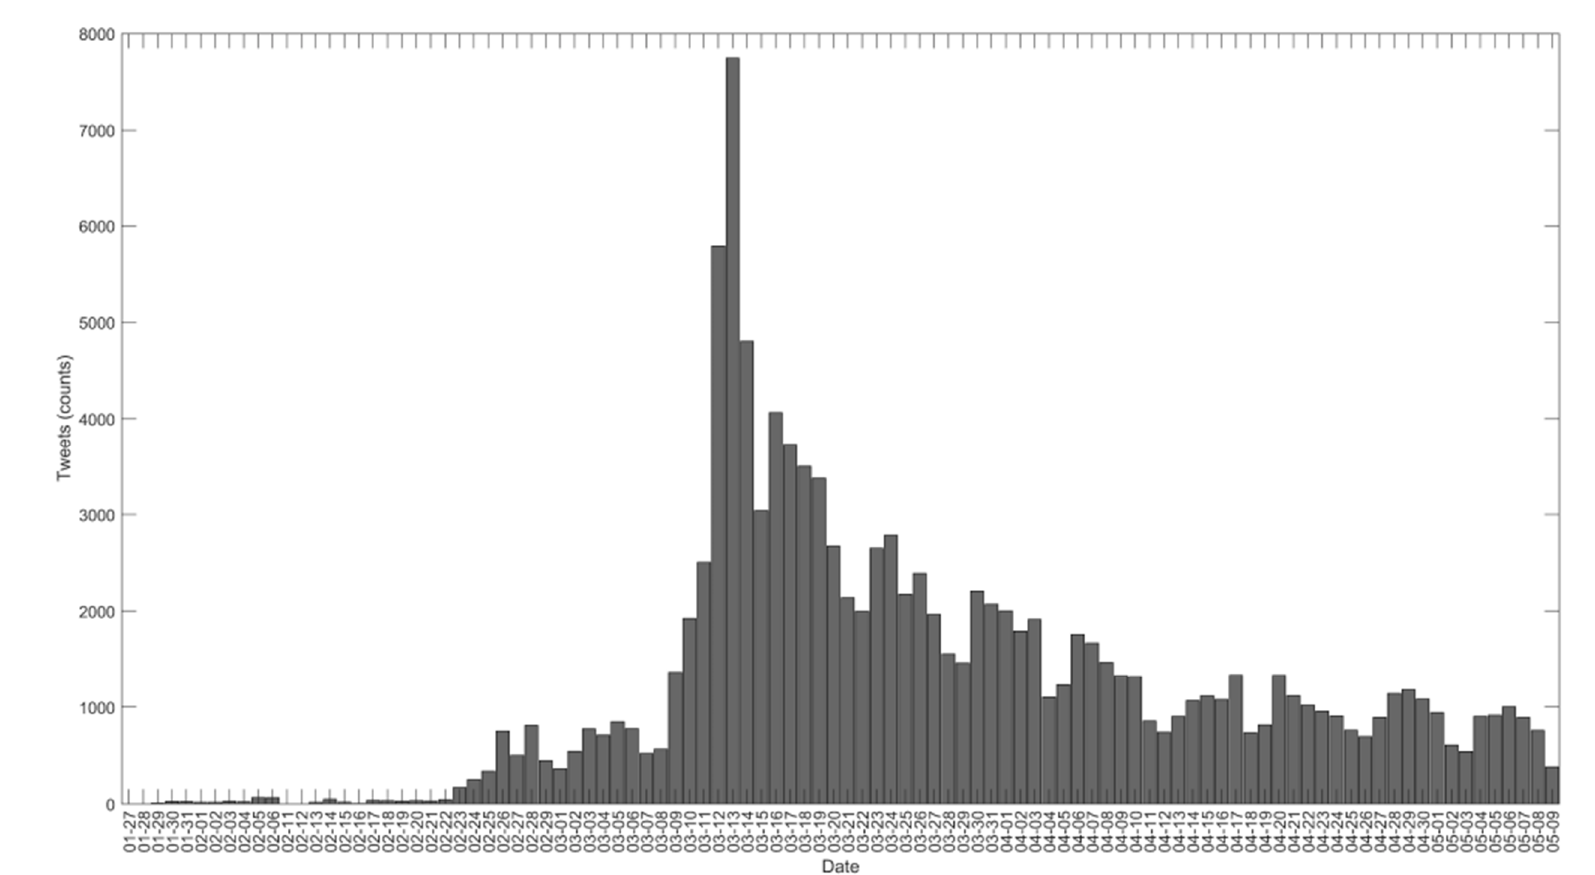
Figure 2. Number of tweets published on sport and COVID-19 during the study period.